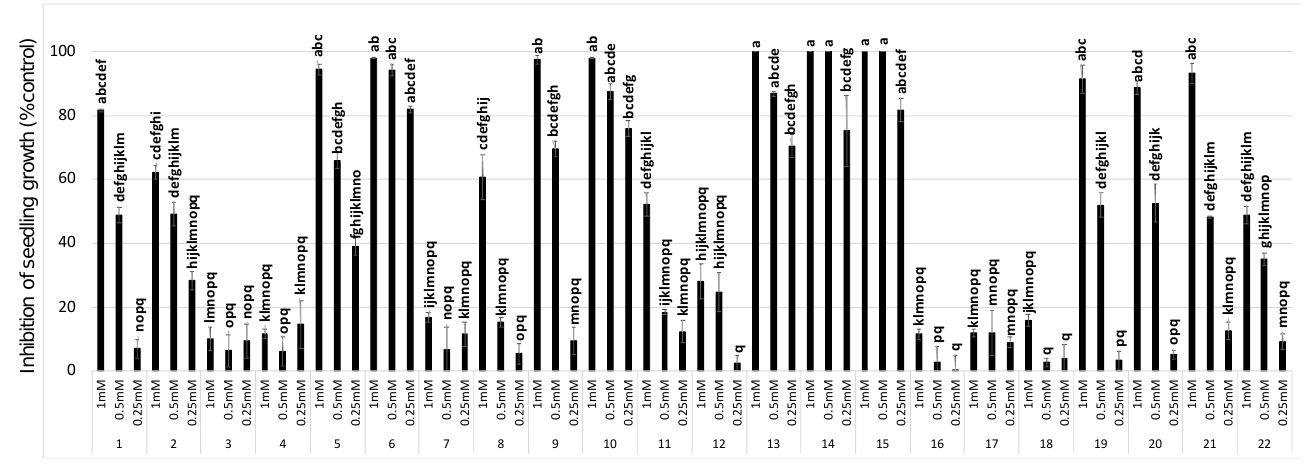
Figure 2. In vitro assessment of the Cuscuta growth inhibition induced by compounds 1 – 22 at concentrations of 1, 0.5, and 0.25 mM. Bars with different letters are significantly different (Tukey test at p < 0.05). Error bars represent the standard error of the mean. Table 1. IC 50 and CLog p values of compounds 1 – 22 , ~1000, inhibition was close to 50% at the highest tested concentration; >1000, compound was far from 50% inhibition at the highest concentration tested but activity was significant; <250, IC 50 was lower than the lowest tested